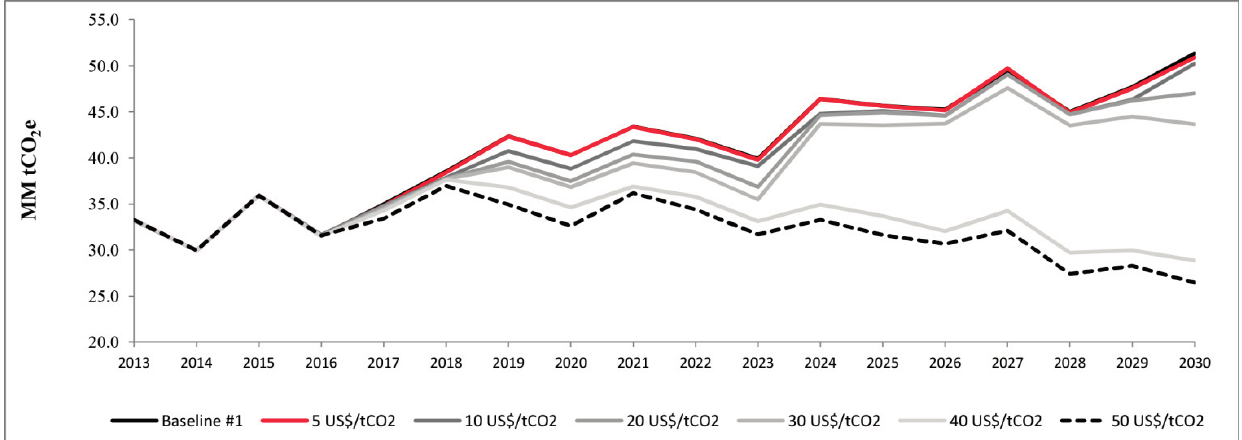
Figure 7. Emissions for baseline scenario #1 in comparison to different scenarios of carbon tax (MM =